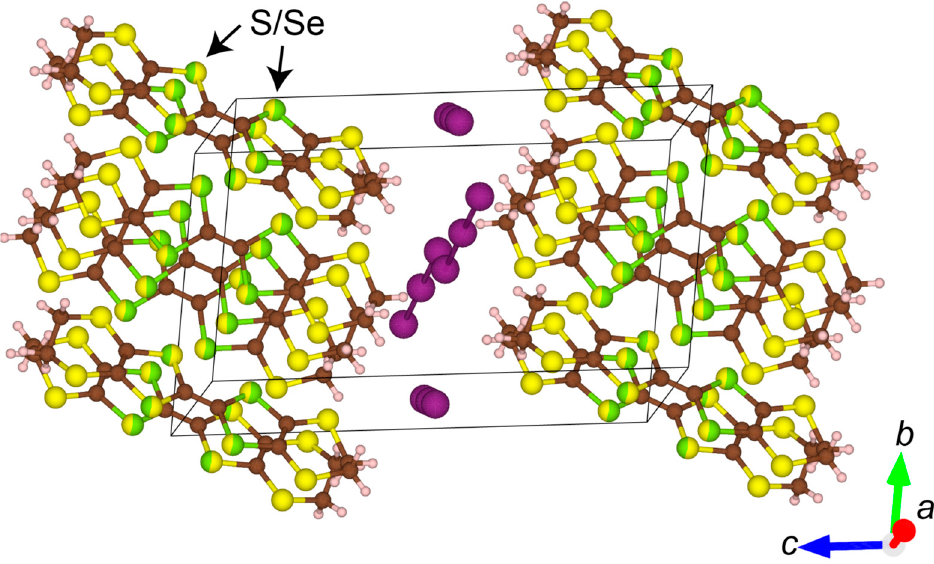
Figure 1. Crystal structure of α -STF 2 I 3 . The brown, yellow, green, blank, and violet spheres denote C, S, Se, H, and I atoms, respectively. The double-coloured (yellow and green) atoms are disordered atoms between S and Se (S: Se = 50%:50%).